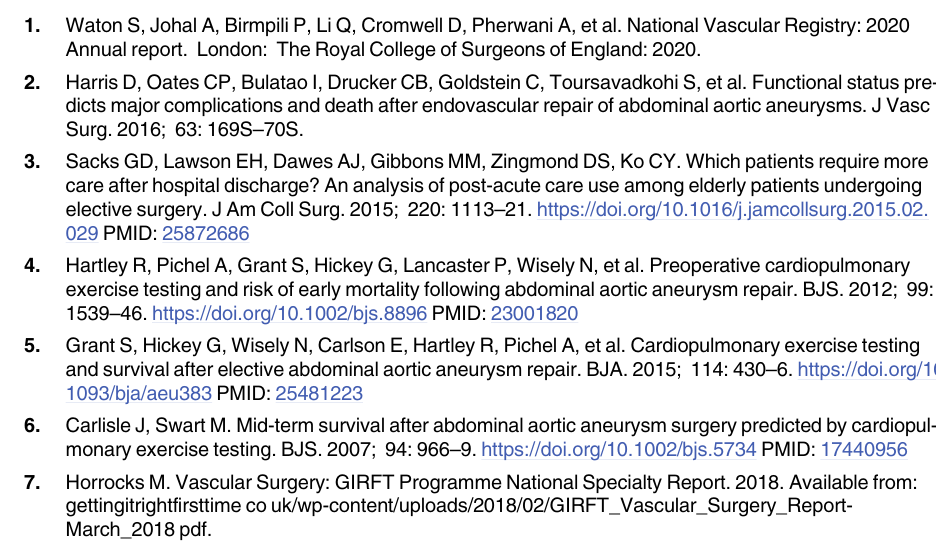
S2 Table. Descriptions of the exercise components used in prehabilitation interventions according to Consensus Exercise Reporting Template